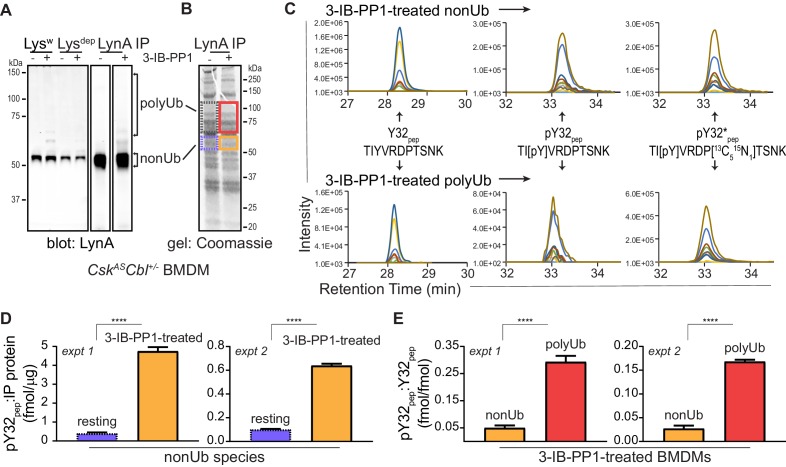
Tyrosine 32 is a site of activation-induced phosphorylation in macrophages.(A) Blots showing immunoprecipitation of LynA from BMDMs derived from CskASCbl+/- mice with (+) or without (-) a 15 s treatment with 3-IB-PP1. Nonubiquitinated (nonUb) and polyubiquitinated (polyUb) LynA species in whole-cell and immunodepleted lysate (Lysw and Lysdep, respectively) and immunoprecipitate (IP) samples are shown. Uncropped immunoblots are shown in Figure 4—figure supplement 1A. (B) Coomassie-stained gel showing regions excised for LC-MS/MS analysis of polyUb LynA (higher boxes) and nonUb LynA (lower boxes); box colors correspond to the bar graphs below. Total IP protein content was quantified by applying densitometry to the whole lane and deriving a mass value via a BSA standard curve, shown in Figure 4—figure supplement 1B. Equivalent amounts of IP material were spiked with 125 fmol isotope-labeled control peptide (pY32*pep, a tryptic peptide containing phosphoY32) and subjected to in-gel trypsin digestion and LC-MS/MS. (C) Tryptic peptides Y32pep (IP-derived unphosphorylated peptide), pY32pep (IP-derived phosphopeptide), and added pY32*pep were quantified by using parallel reaction monitoring (PRM) to collect MS/MS spectra for peptide parent ions 687.3267 and 690.3336 m/z, respectively. Extracted ion chromatograms (XICs) were derived from Skyline for MS/MS fragment ions corresponding to y and b fragments from Y32, pY32, and pY32* peptides and used to quantify the ratios of pY32pep:pY32*pep or pY32pep:Y32pep. Representative ion-annotated XICs are shown in Figure 4—figure supplement 2. Assignment of XIC peaks using synthetic peptides is shown in Figure 4—figure supplement 3. Detection of phosphopeptides in IP samples is shown in Figure 4—figure supplement 4. Peptide calibration curves are shown in Figure 4—figure supplement 5. (D–E) Quantitative analysis of Y32 phosphorylation in resting and 3-IB-PP1-treated BMDMs, including nonUb species from resting BMDMs (blue dotted), nonUb species from 3-IB-PP1-treated BMDMs (orange), and polyUb species from 3-IB-PP1-treated BMDMs (red). Although we analyzed a gel fragment that could contain polyUb species in resting BMDMs (gray dotted), this species was so rare as to be unquantifiable. Error bars represent the standard deviation (stdev) of n = 3 technical replicates. Data from two biological replicates are shown side by side. (D) Quantification of pY32pep in nonUb species from resting vs. 3-IB-PP1-treated BMDMs normalized to the total protein content of each IP. This analysis was used only for nonUb samples, which were roughly equimolar in resting and 3-IB-PP1-treated BMDMs. Sig. from two-tailed t tests for each experiment: [nonUb resting vs. nonUb 3-IB-PP1-treated, asterisks]; ****p<0.0001. (E) Quantification of pY32pep in nonUb vs. polyUb species in 3-IB-PP1-treated BMDMs normalized to the amount of unphosphorylated Y32 pep. Sig. from two-tailed t tests for each experiment: [nonUb resting vs. nonUb 3-IB-PP1-treated, asterisks]; ****p<0.0001. Refer to Figure 4—source data 1. Raw mass spectrometry files are available at the Panorama repository http://panoramaweb.org, http://panoramaweb.org/Freedman_LynA.url, ProteomeXchange ID: PXD014621).10.7554/eLife.46043.027Figure 4—source data 1.Summary quantification of pY32 peptide from LC-MS/MS data.